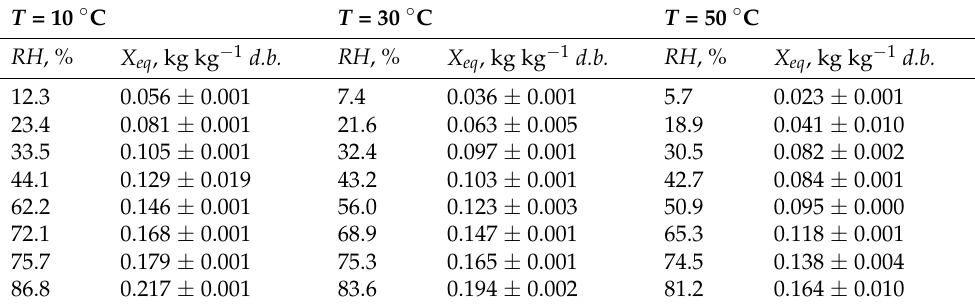
Table A1. The experimental mean values of equilibrium moisture content X eq and standard deviations for all sets of temperatures T and relative humidity RH observed from the gravimetric salt